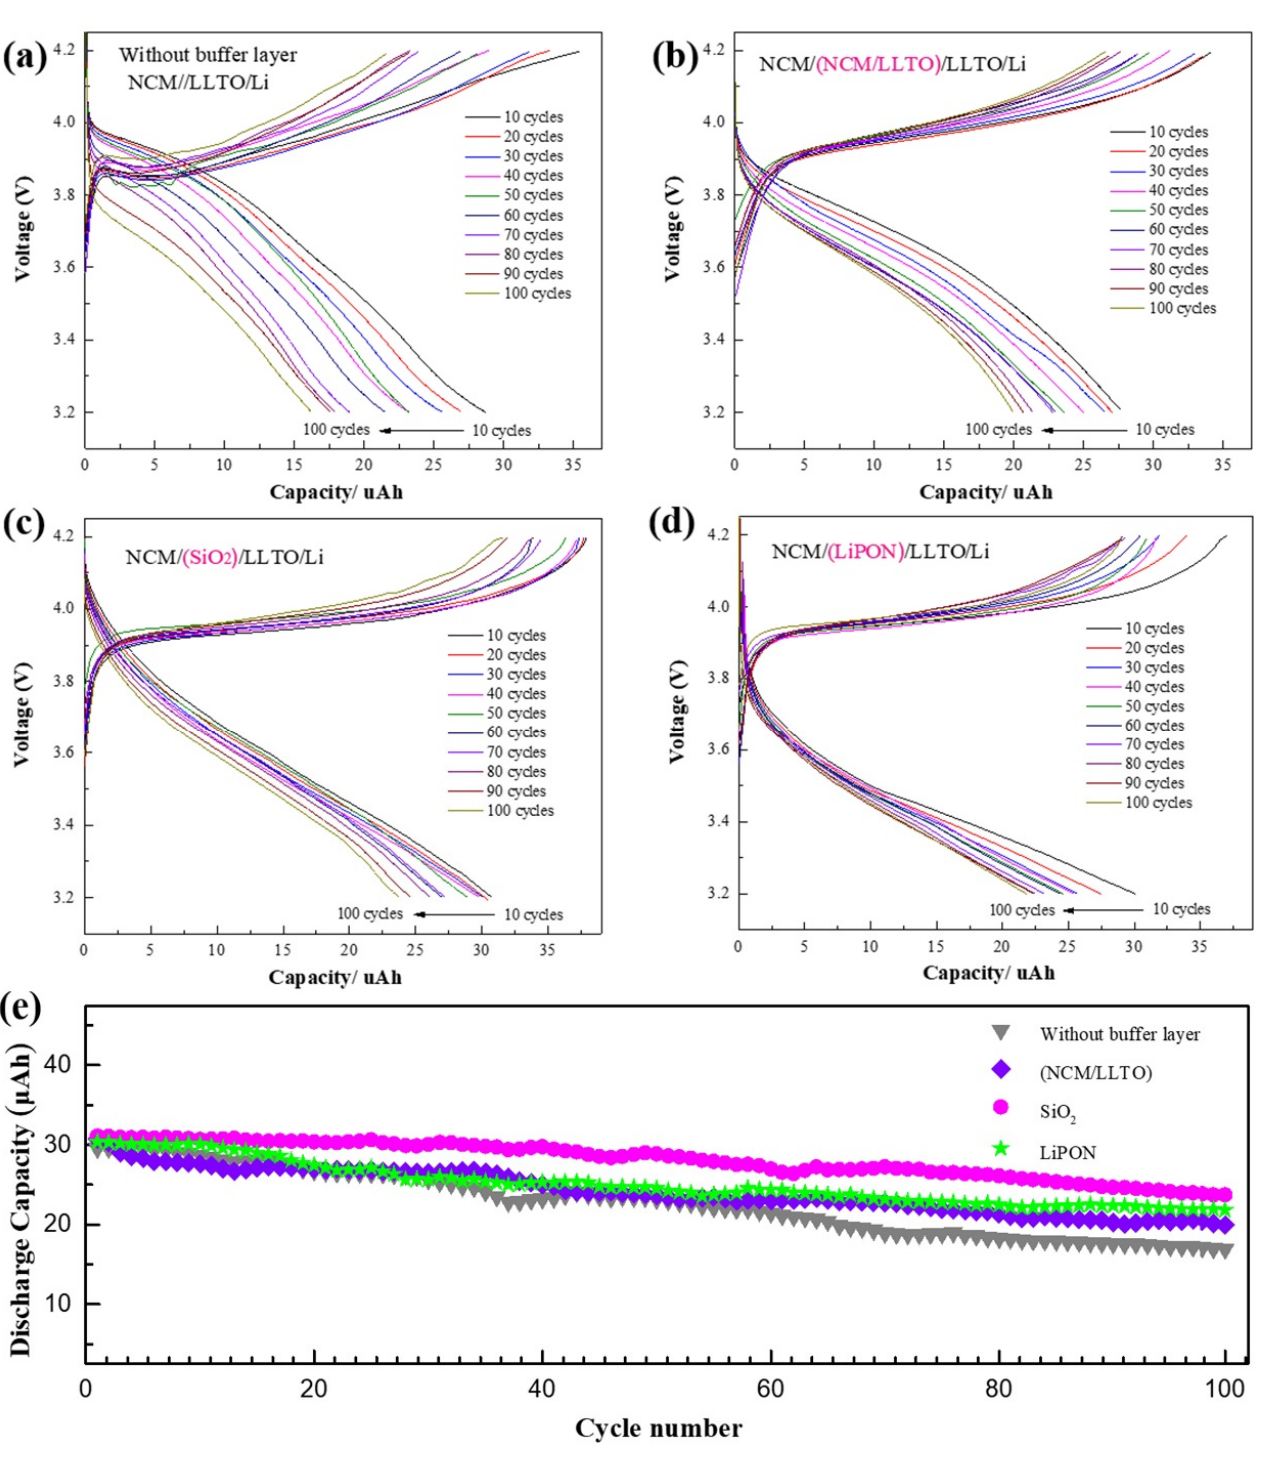
Figure 4. Cycle characteristics of battery with different buffer layer, capacity remained after 100 cycles at a 1 C rate between 3.2 and 4.2 V for battery with different interface structure: ( a ) NCM/LLTO, ( b ) NCM/(LLTO/NCM)/LLTO, ( c ) NCM/SiO 2 /LLTO, ( d ) NCM/LiPON/LLTO, ( e ) performance of first 100 cycles for cells with different buffer layer.